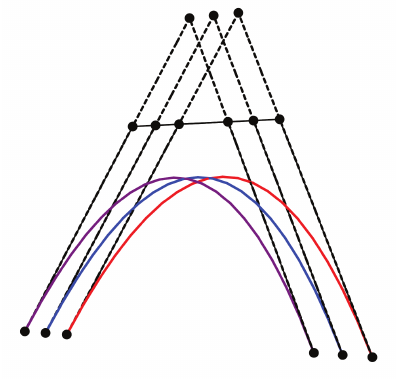
Figure 7. Fuzzy cubic B.B